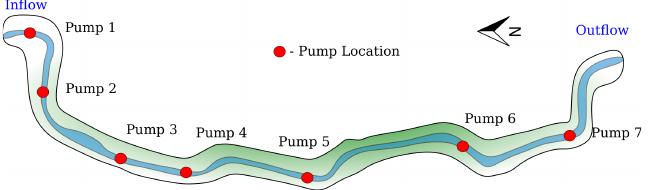
Figure 19. Location of the seven pumps. Image designed with